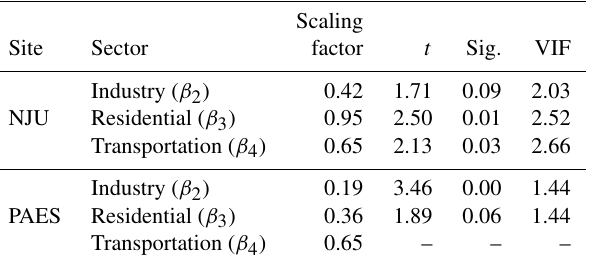
Table 4. The scaling factors and statistical indicators from the mul- tiple regression model in Case